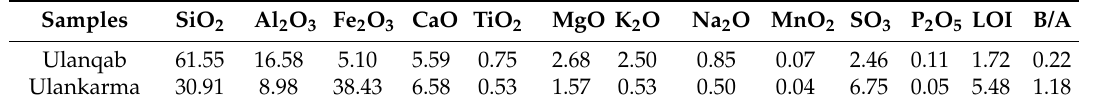
Table 2. Percentages of major element oxides (%), and loss on ignition (LOI, %), and base to acid ratio (B/A).